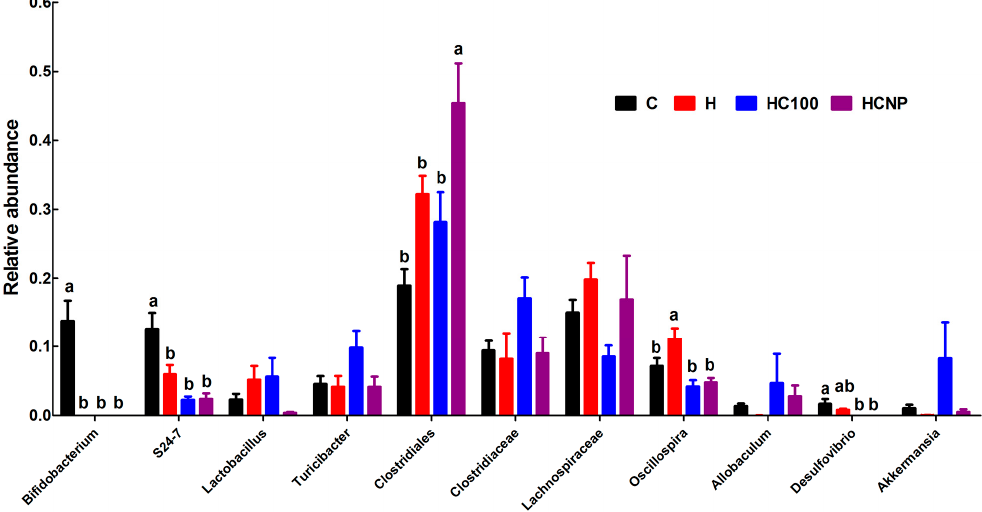
Figure 7. E ff ects of curcumin on gut microbiota at genus level. C, corn starch diet-fed rats; H, high-carbohydrate, high-fat diet-fed rats; HC100, high-carbohydrate, high-fat diet-fed rats given 100 mg / kg / day curcumin; HCNP, high-carbohydrate, high-fat diet-fed rats given 5 mg / kg / day curcumin nanoparticles.